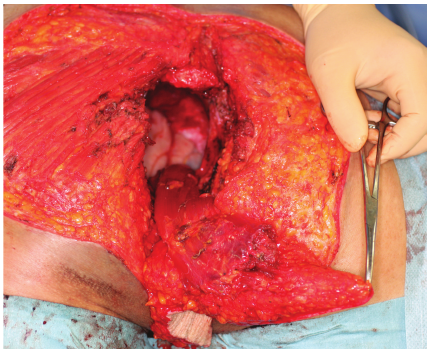
Figure 5: According to the first extent of tumor, buttock skin was excised together with sacrococcyx, and rectum. Reconstructive surgery by musclocutaneous flap of abdominal rectus muscle and colostomy was performed.